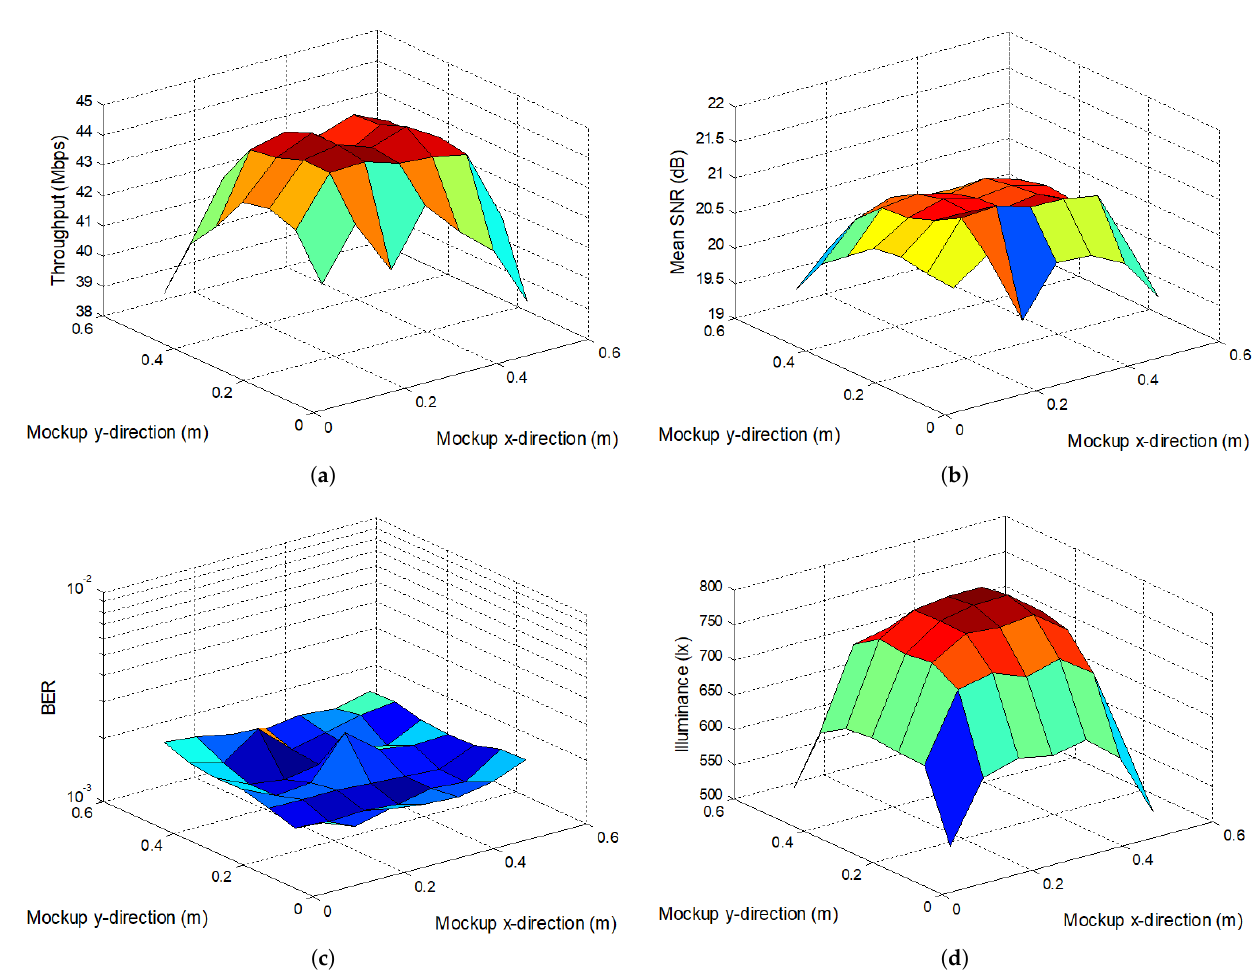
Figure 15. Experimental results for mockup without walls when the four lamps transmit the same data: ( a ) Measured throughput ( R max = 44.8 Mbps, R mean = 42.8 Mbps, R min = 38.9 Mbps). ( b ) Measured mean SNR (SNR max = 21.2 dB, SNR mean = 20.5 dB, SNR min = 19.4 dB). ( c ) Measured BER (BER max = 2.4 × 10 − 3 , BER mean = 1.7 × 10 − 3 , BER min = 1.4 × 10 − 3 ). ( d ) Measured illuminance ( E max = 795 lx, E mean = 681 lx, E min = 500